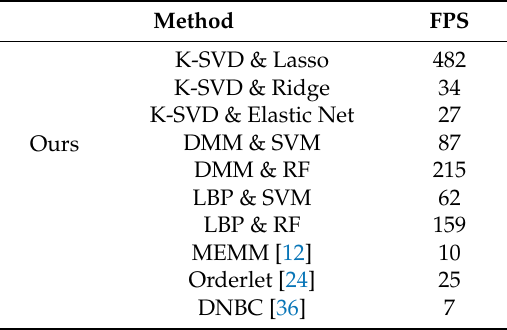
Table 4. Comparison of the computational